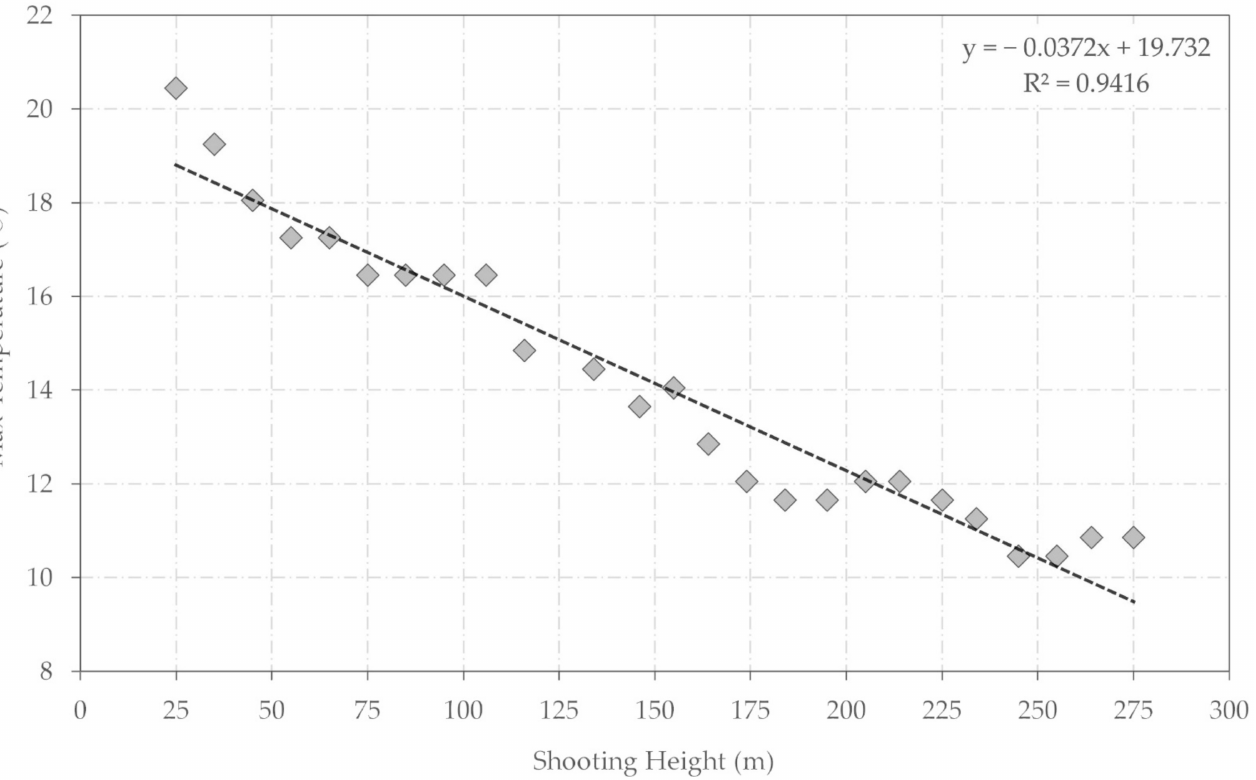
Figure 8. Regression analysis of maximum temperature and shooting